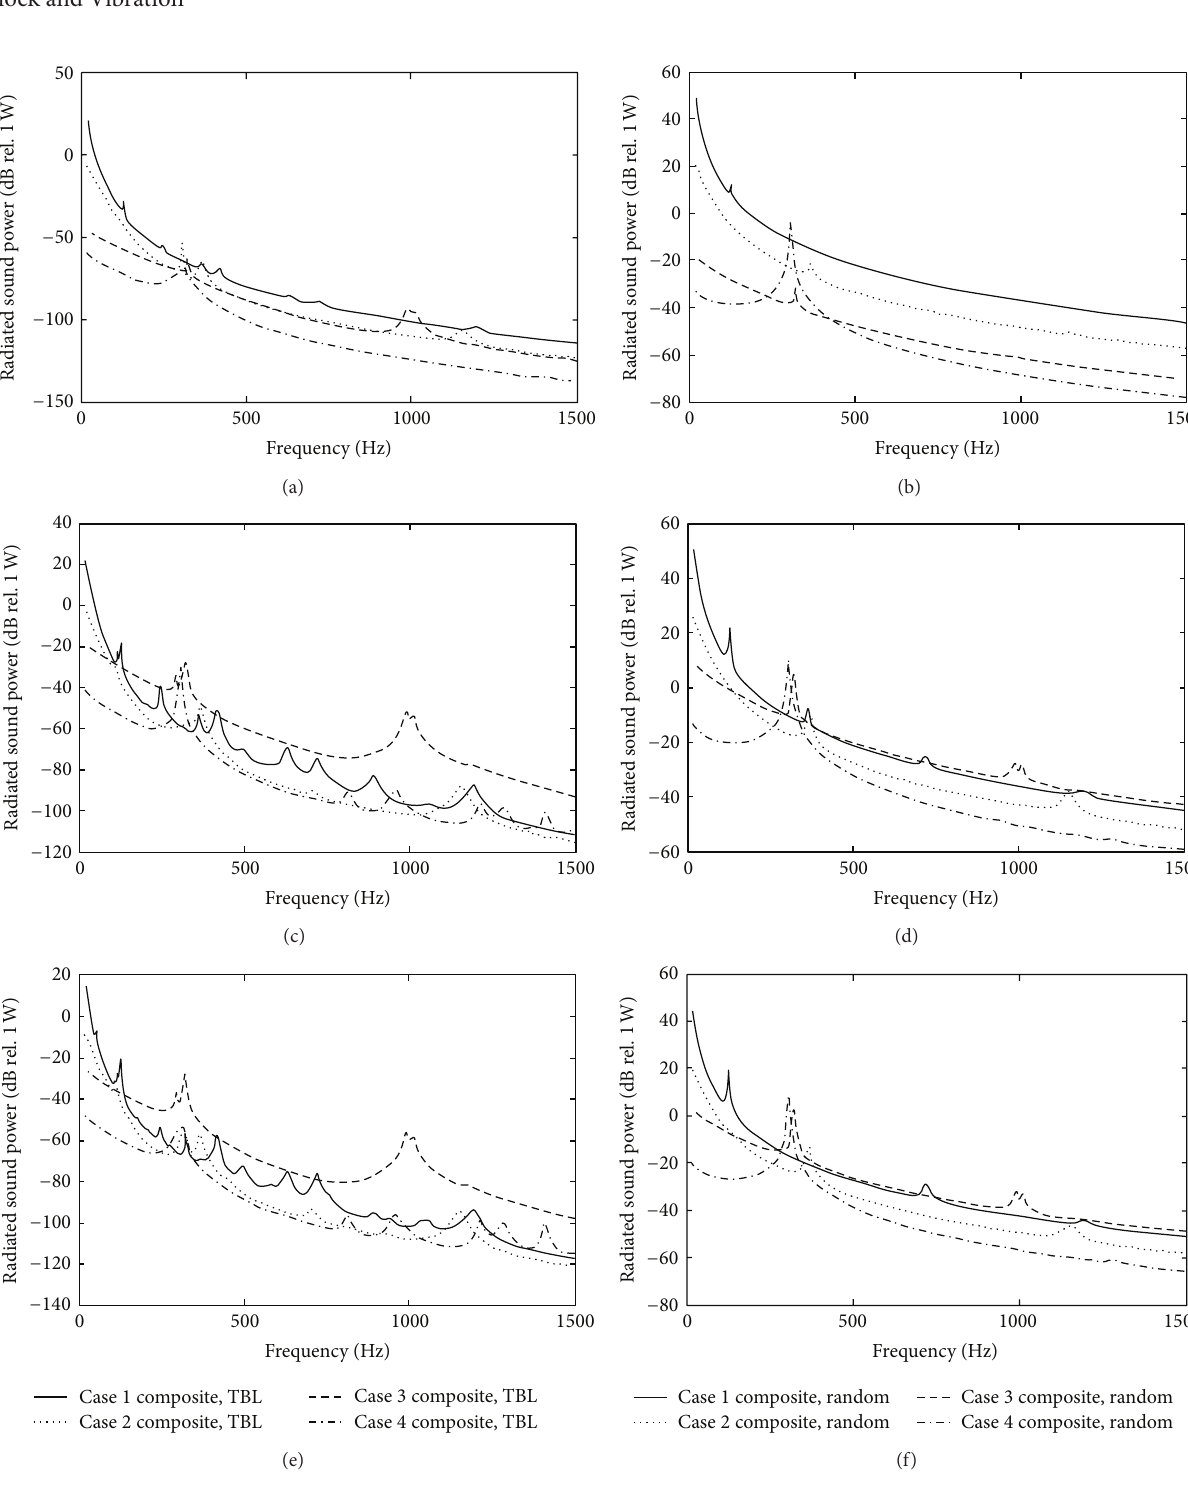
, 𝑦 ) = (0.3𝑎, 0.2𝑏) . 2 2